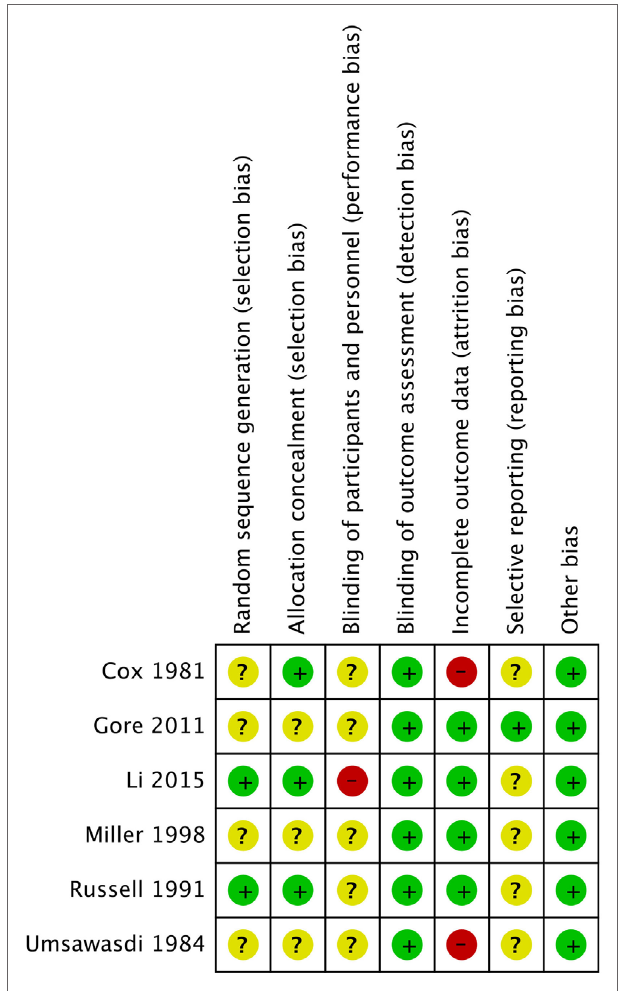
FigURe 2 | Risk of bias assessment for the included